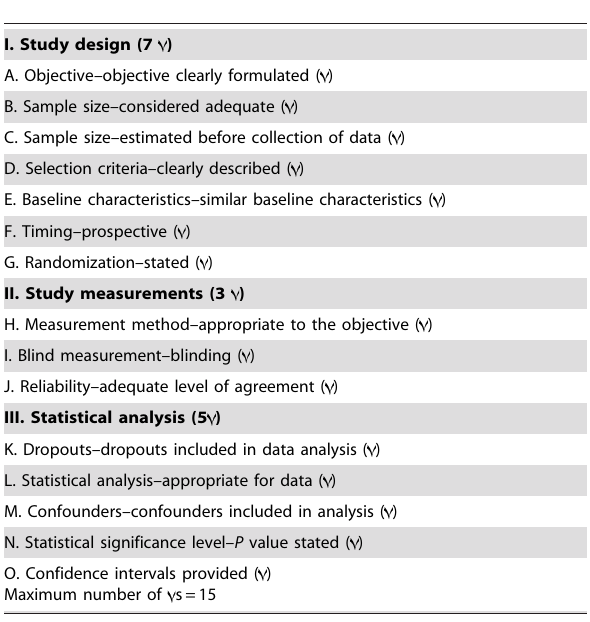
Table 2. Quality assessment